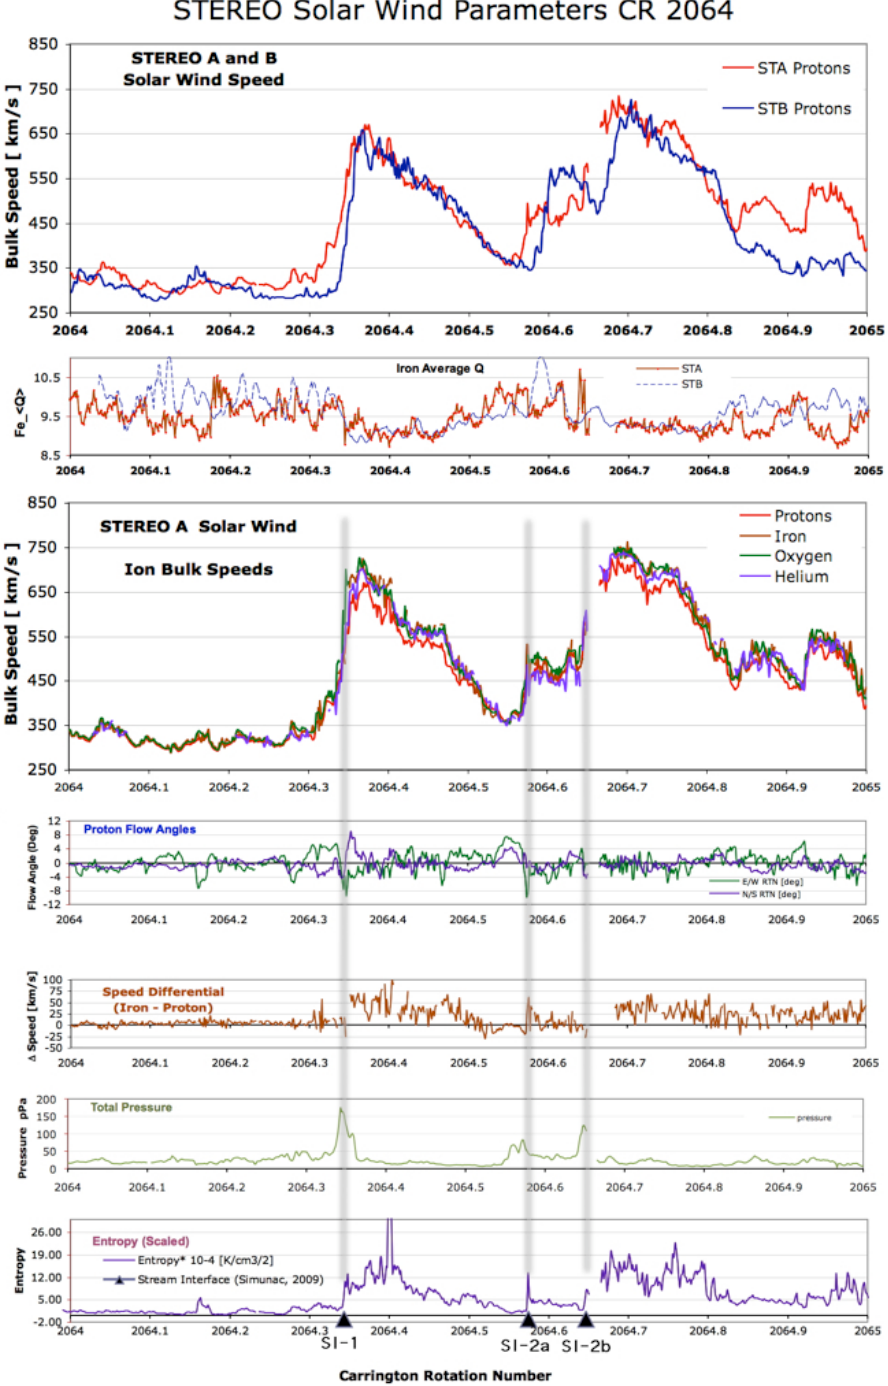
Fig. 6. Solar wind overview of Carrington Rotation Number 2064 as observed by STEREO A (STA) and STEREO B (STB). From top to bottom: bulk speed profile for protons during Carrington Rotation Number 2064 observed at STEREO A (3–30 December 2007) and STEREO B (30 November–27 December 2007); average Fe charge state for STEREO A and B; Ion bulk speeds observed by STEREO A for protons, helium, oxygen, and iron; Proton bulk flow directions (E/W, N/S) in the RTN frame of reference at STEREO A; Speed differential between iron and protons at STEREO A; Total pressure (magnetic and plasma – ion and electron) at STEREO A; Entropy (scaled) and Stream interfaces (SI-1, SI-2a, SI-2b) as determined by Simunac (2009) at STEREO